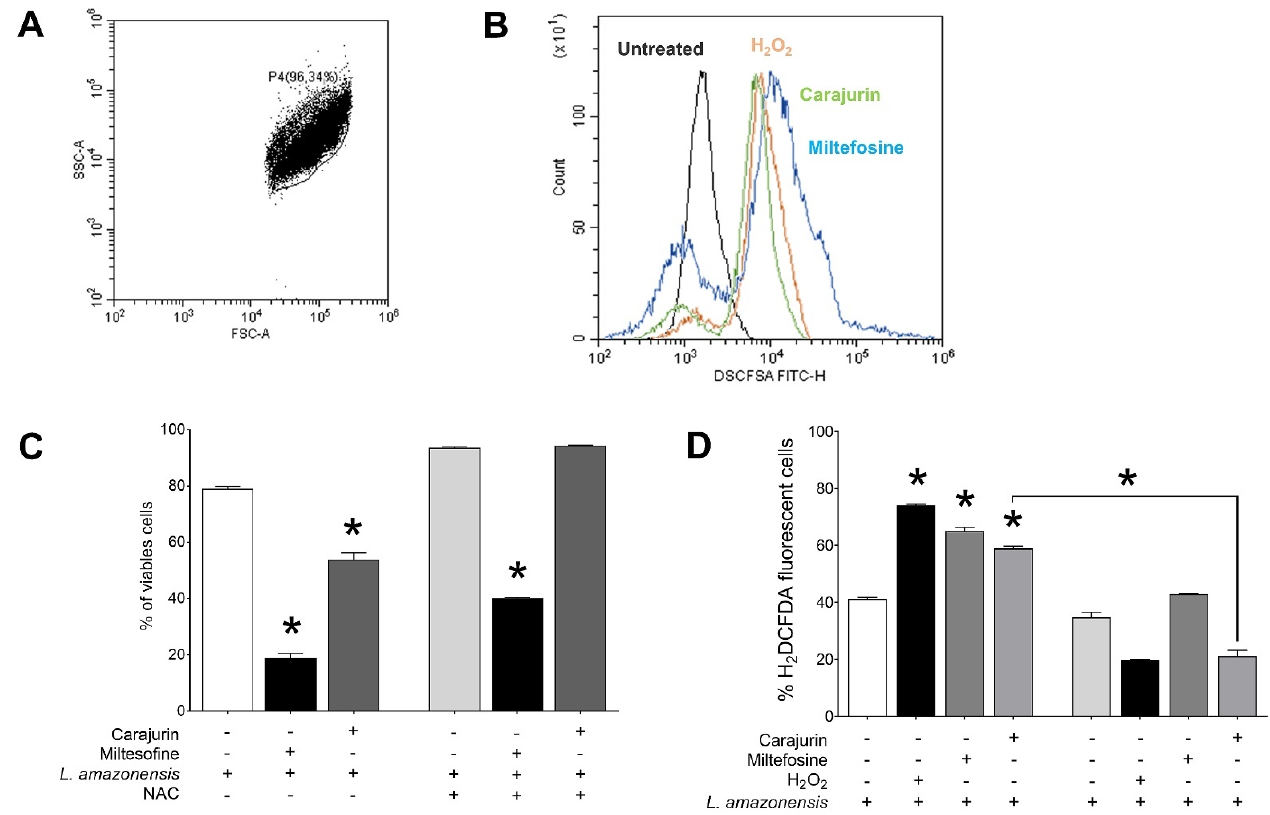
Figure 5. Evaluation of intracellular ROS levels in Leishmania amazonensis promastigotes and effect of N-Acetyl-L-cysteine on carajurin-induced cell death after incubation with carajurin for 24 h. ( A ) Promastigotes captured in the gated region and representative histogram. ( B ) The green line shows increased ROS production in parasites treated with carajurin, at the IC 50 concentration (26.4 μ M), when compared to control parasites (black line). The same was observed in the group treated with H 2 O 2 (orange line) and miltefosine (blue line). ( C , D ) Promastigotes were cultivated in the presence of N-Acetyl-L-cysteine (NAC, 300 μ M) and carajurin (IC 50 concentration, 26.4 μ M). Miltefosine